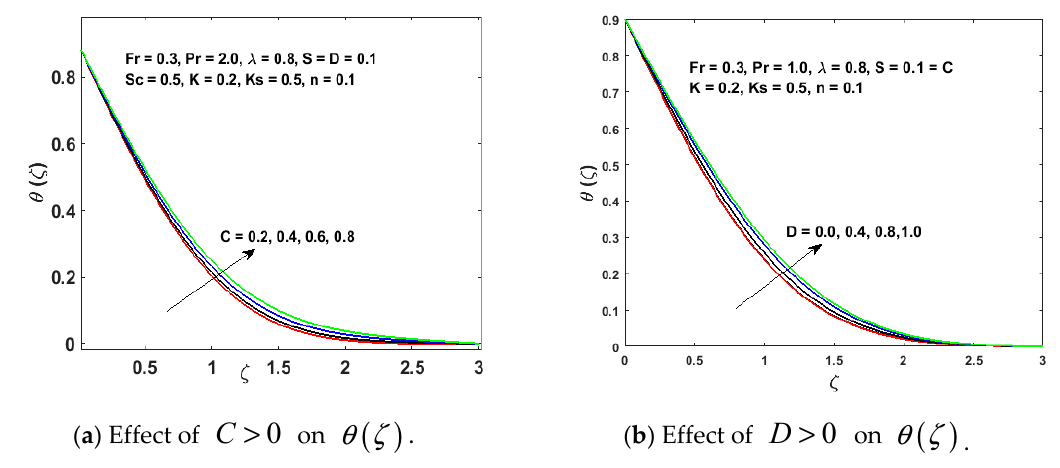
( ) θ ζ . Figure 5. E ff ect of the Prandtl number (Pr) on θ ( ζ ) .